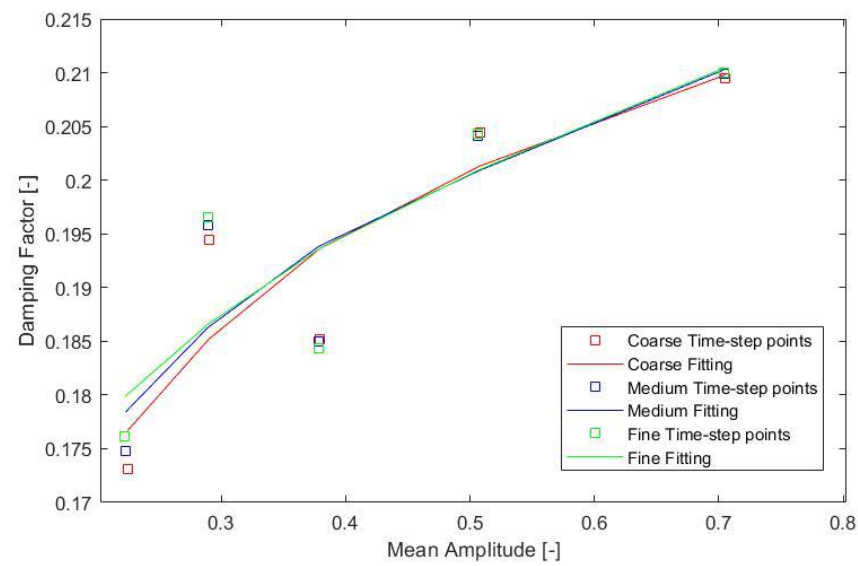
Figure 5. Cubic fitting for the time dependency study where all the time-steps showed similar behaviour with increased differences in the latter periods.